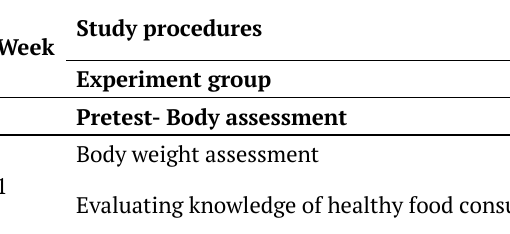
Table 1. Programmes for